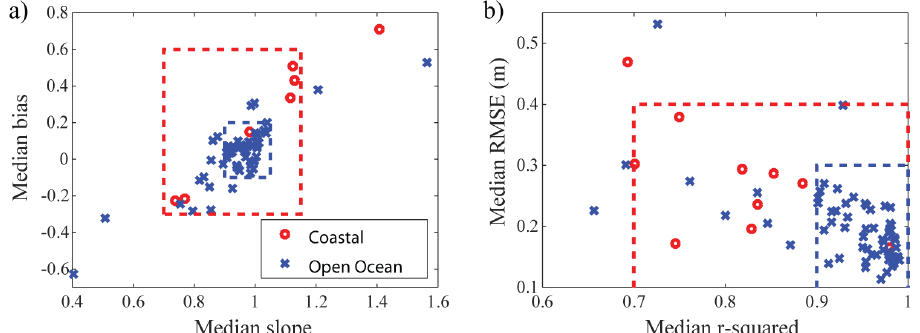
Figure 11. General assessment using the median of the estimates from the Jason-3 retrackers. ( a ) bias and slope values; ( b ) Correlation ( r 2 ) and RMSE. In both plots, red points are for those within 15 km of the coast, and blue those further away, and the dashed lines show the selection criteria to discard outliers and give a consistent dataset.